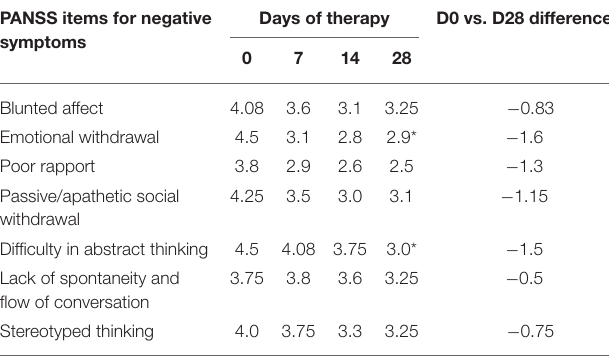
TABLE 3 | Changes in baseline scores for positive, negative, and extrapyramidal symptoms during 28 days of treatment with cariprazine (1.5–6 mg/day). Scale